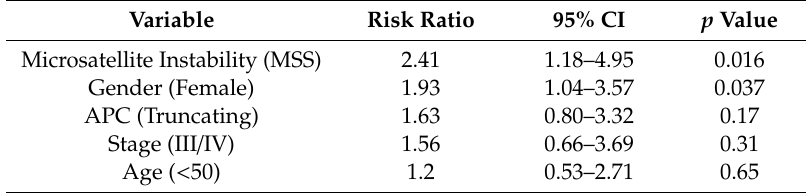
Table 5. Cox-proportional Hazard analysis of survival of BRAF mutant